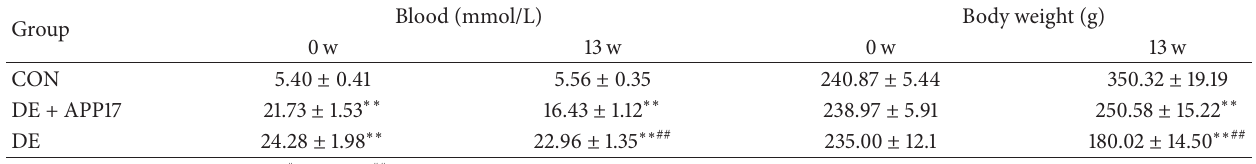
Table 1: Blood glucose and body weight of mice in 3 groups ( 𝑥 ± 𝑠 , 𝑛 = 1). Different letters represent the significant difference at 𝑃 < 0.05. Group